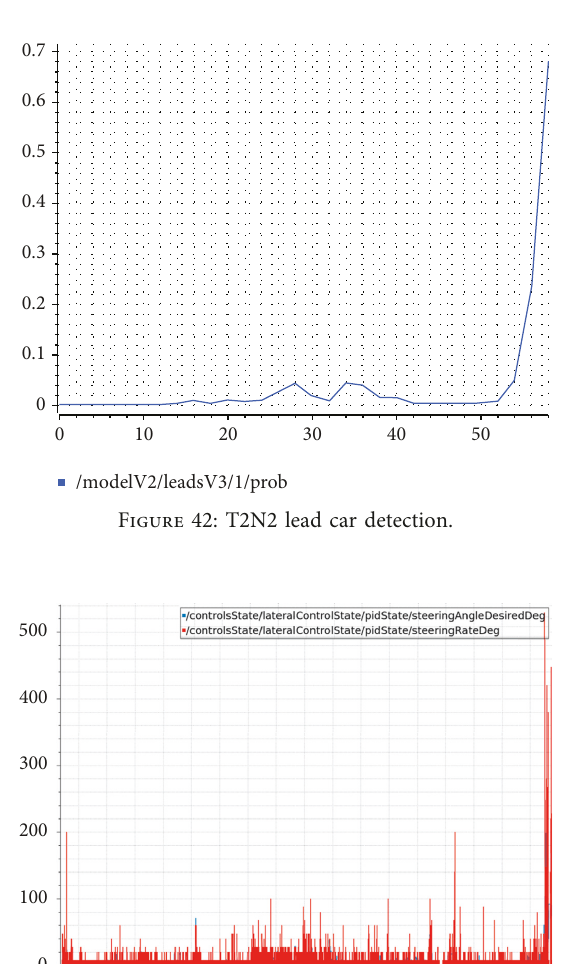
Figure 44: T2D1 temperatures.